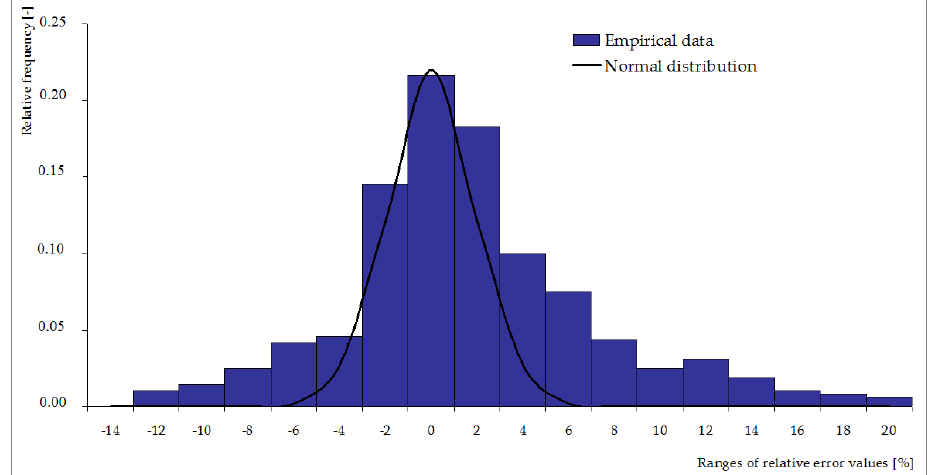
Figure 14. Distribution of errors in estimating the maximum queue size at signal-controlled intersec-